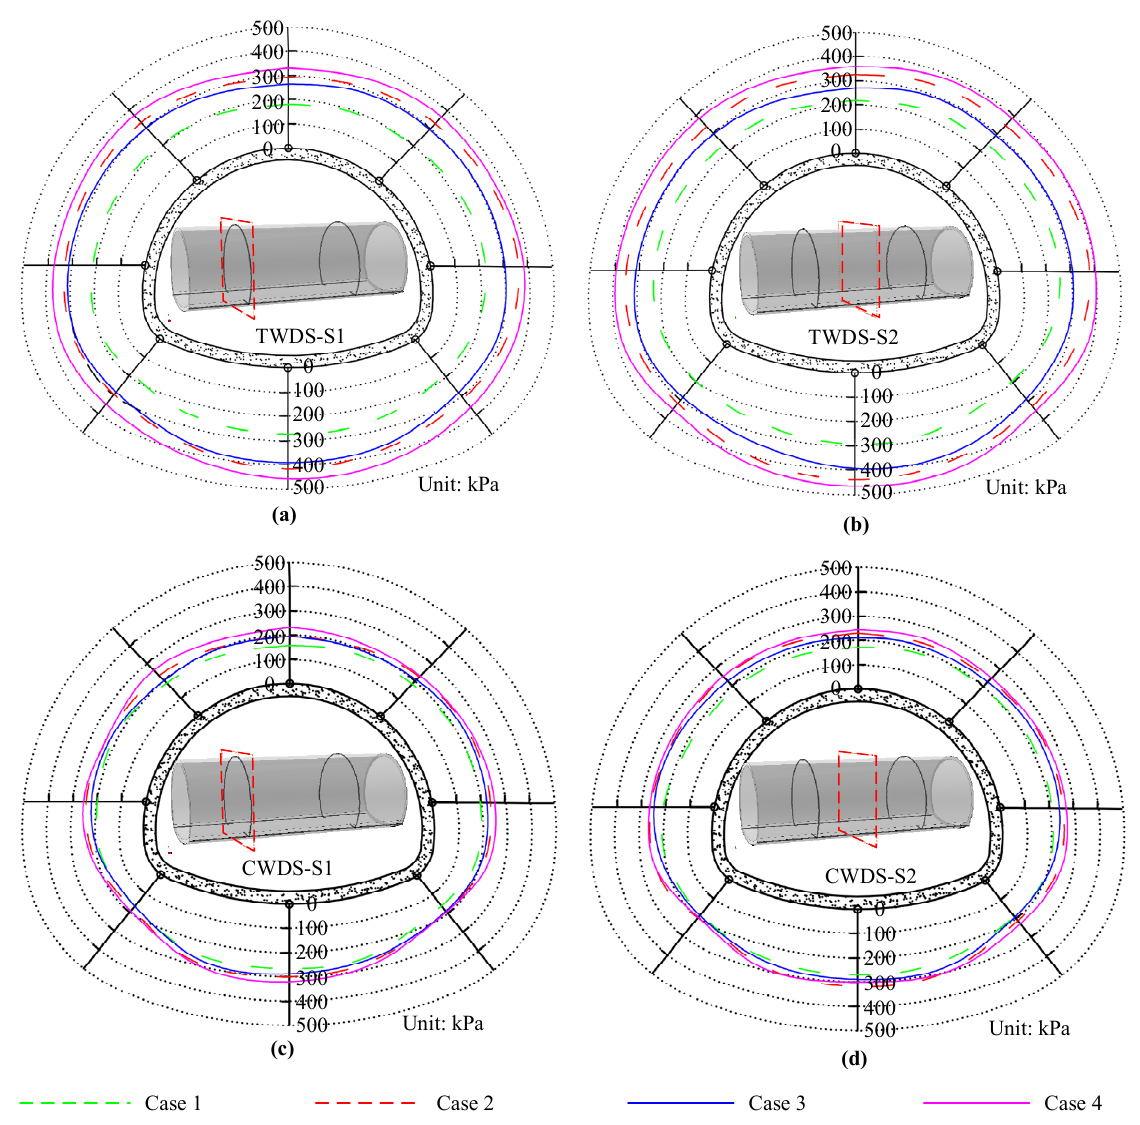
Figure 9. The distribution of water pressure under different work conditions: ( a ) Section 1 of TWDS; ( b ) Section 2 of TWDS; ( c ) Section 1 of CWDS; ( d ) Section 2 of CWDS.